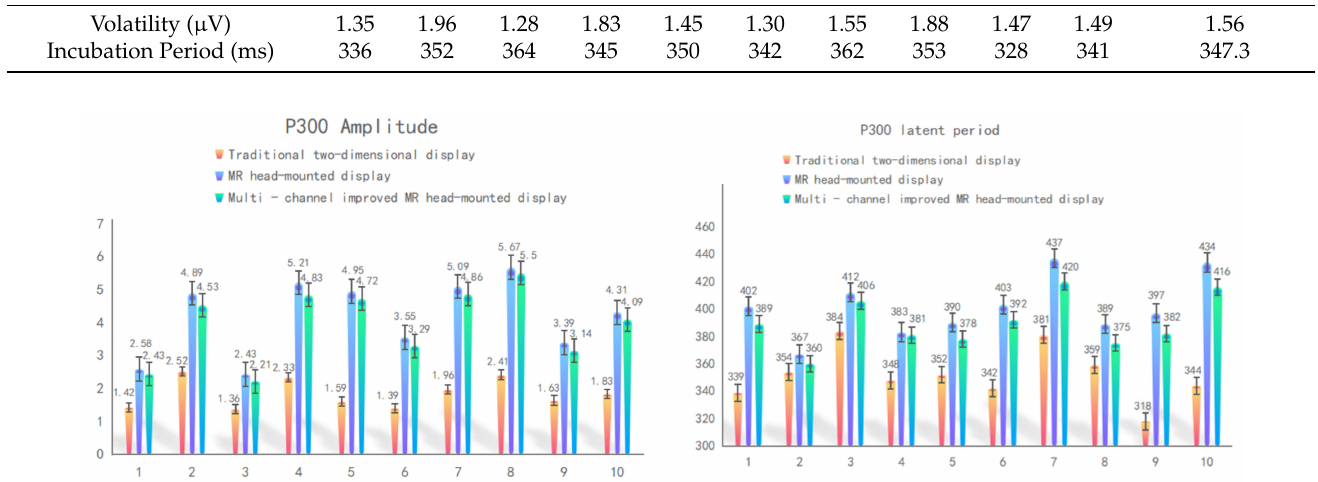
Figure 21. Subject’s P300 EEG data in three display interaction systems. By analyzing the P300 EEG data, the average P300 amplitude and latency of the multi- channel improved MR display interaction system were 1.56 and 347.3, respectively. The amplitude and latency are lower than those of the conventional 2d display interaction system and the unmodified MR display interaction system.